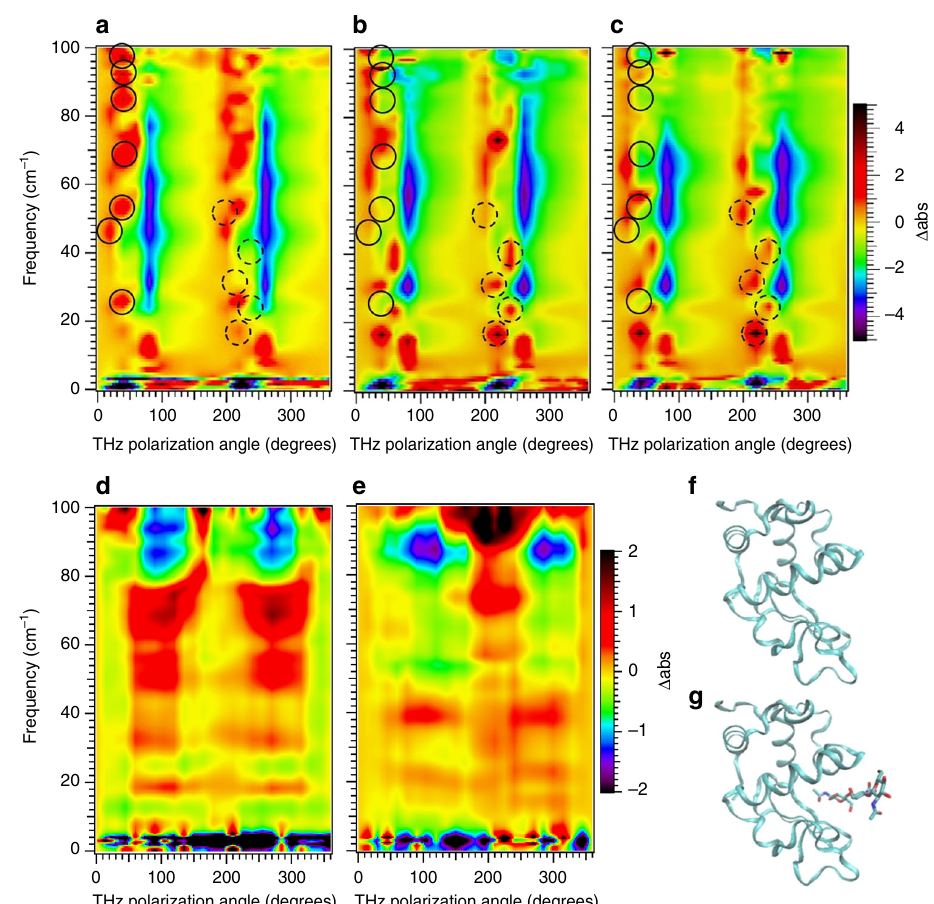
Fig. 4 PV-ATM sensitivity to inhibitor binding. a CEWL; b CEWL-3NAG crystal 1, and c CEWL-3NAG crystal 2. The spectra is reproducible crystal to crystal. ATM measurements are shown for comparison ( d ) CEWL and e CEWL-3NAG. The simpler and faster PV-ATM technique provides spectra with increased structure over the ATM method. For the PV-ATM results solid circles indicate spectral features that are present in free CEWL and absent in inhibitor bound CEWL. Dashed circles indicate features present for inhibitor bound CEWL and absent for free CEWL. These are offset by 180° from the solid circles since all features have 180° periodicity from the regular alignment of the molecules. The large changes with inhibitor binding indicate the features arise from intramolecular vibrations and not crystal phonons. The crystal phonons are dependent on the intermolecular surface contacts and molecular mass, which change only slightly with binding as indicated by the X-ray structures for f free (1bwh.pdb) and for g inhibitor bound